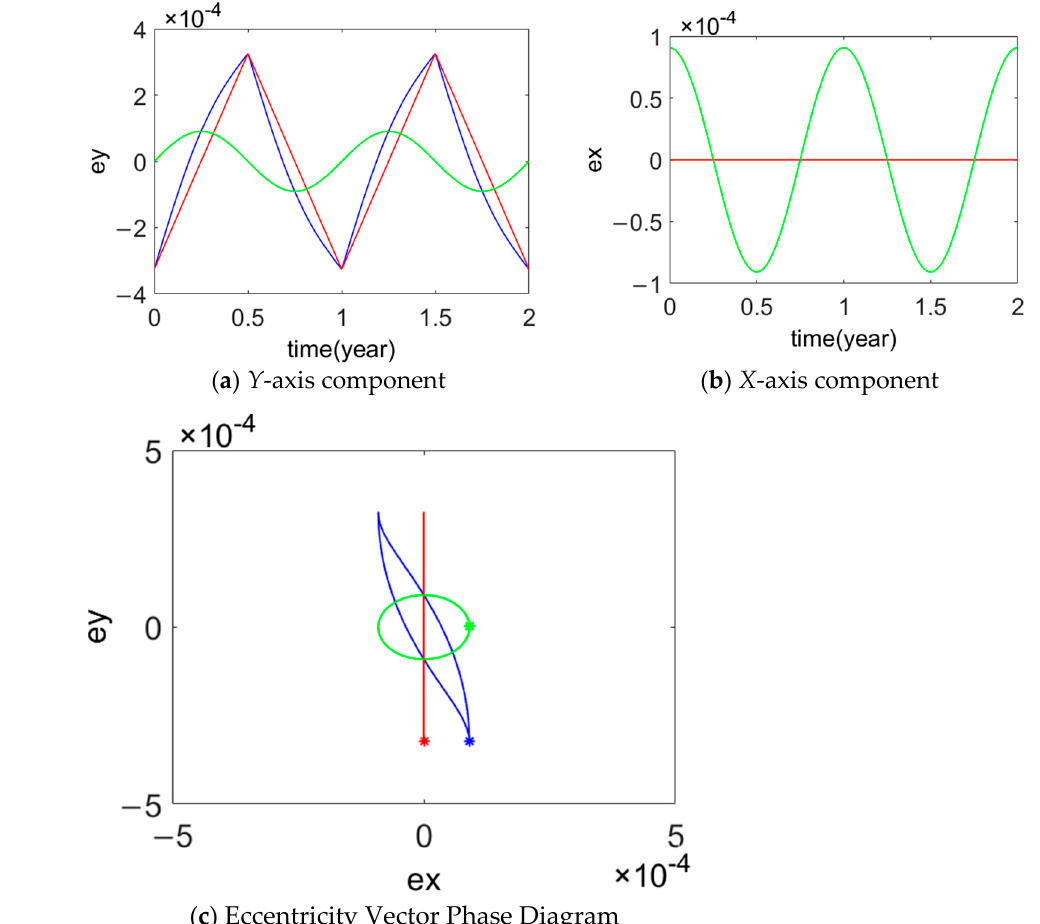
Figure 4. Mean eccentricity vector in one nutation period.